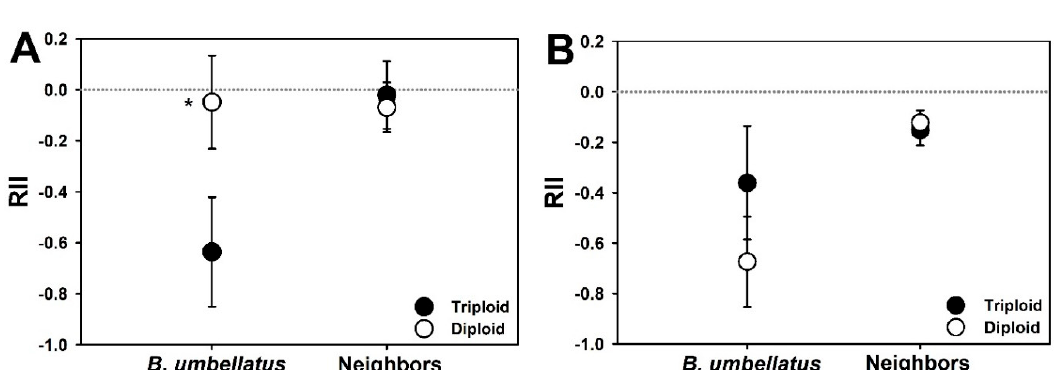
Figure 2. Mean ( ± 95% Confidence Interval) relative interaction intensities (RII) for flowering rush cytotypes and neighbors grown in experimental communities under submersed ( A ) or emergent ( B ) conditions. White circles are RII values of diploid plants (or neighbors grown with diploid plants) and black circles are RII for triploid plants (or neighbors grown with triploid plants). The more negative RII values correspond to a greater e ff ect of competition. Significant di ff erences ( p < 0.05) between cytotype means (i.e., their 95% CI do not overlap) are indicated by an asterisk. If confidence intervals of a mean do not overlap zero (e.g., neighbor means in panel B ), the interpretation is that of a significant competitive e ff ect for that treatment. For example, in panel ( A ), triploid and diploid RII means are significantly di ff erent to each other, but diploid RII is not significantly di ff erent to zero (i.e., no e ff